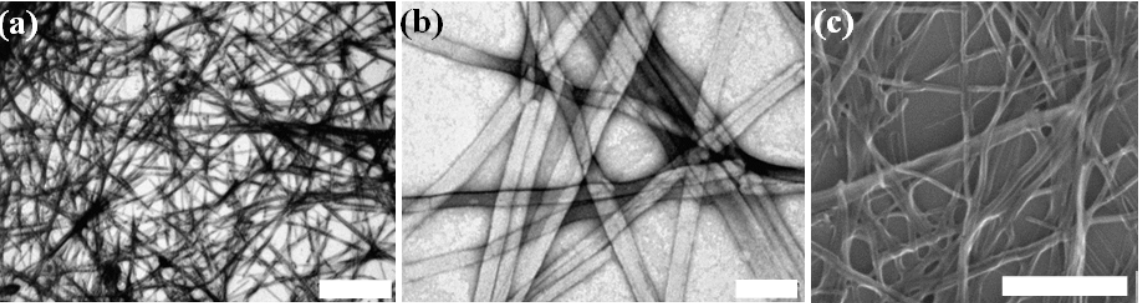
Figure 2. The DOPA-containing peptide Asp-DOPA-Asn-Lys-DOPA assemblies. High-resolution microscopy of fibrillar assemblies formed by 6 mM Asp-DOPA-Asn-Lys- DOPA in water. ( a , b ) Transmission electron microscopy (TEM) micrographs, negative staining was applied; Scale bars represent 2 µm and 100 nm; ( c ) scanning electron microscopy (SEM) micrograph, scale bar represents 1